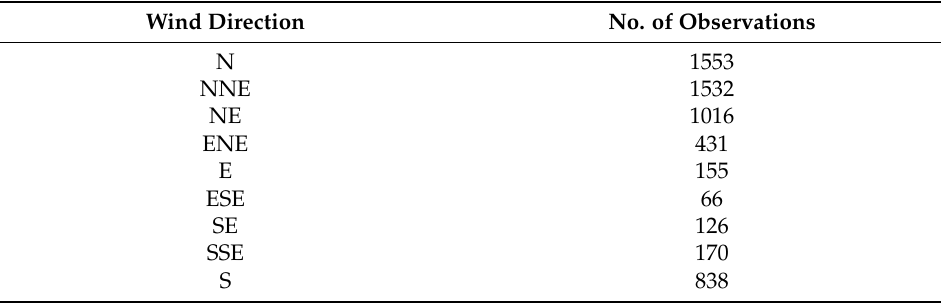
Table A1. Frequency of wind direction